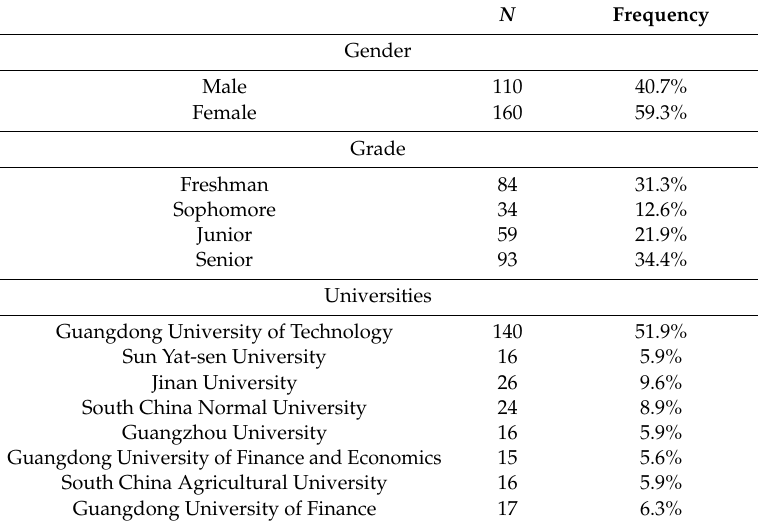
Table 5. Demographic details for the final sample ( N =